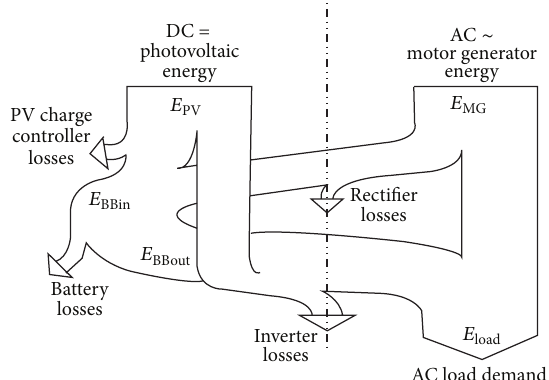
Figure 5: Energy flow diagram for a typical PV/diesel hybrid system